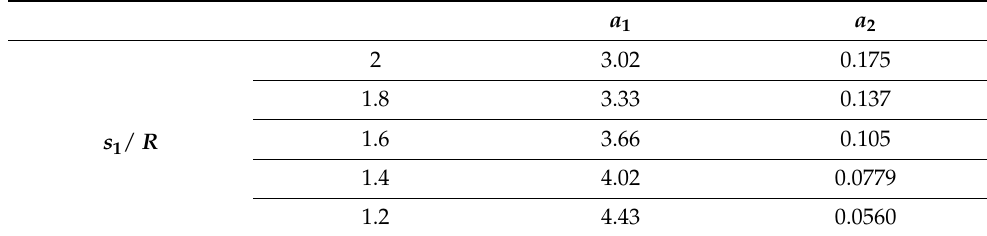
Table 3. Calculation of parameters a 1 and a 2 as a function of the ratio ( s 1 /R ), characterising the degree of overlapping of critical impact zones from neighbour